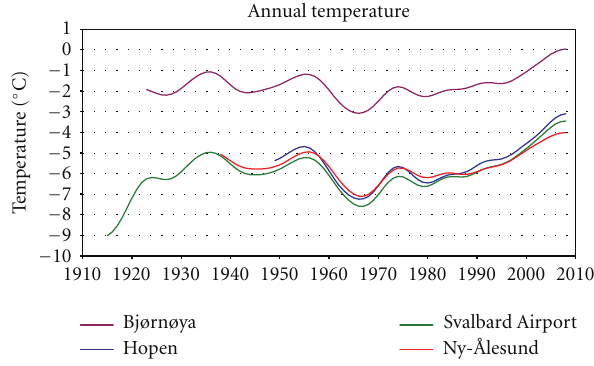
Figure 2: Annual temperature development at weather stations in the Svalbard region. The lowpass filtered series are smoothed by Gaussian weighting coe ffi cients and show variability on a decadal time scale. The curves are cut three years from start and end.